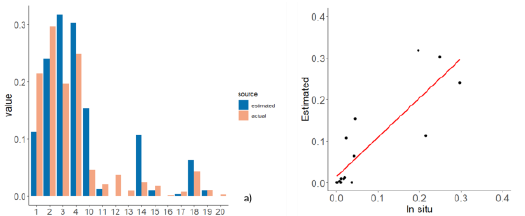
Figure 9. Results of the validation of fractional vegetation cover maps over the 15 ESU: estimated and actual FVC values for each ESU (a) and regression between estimated and in situ FVC values